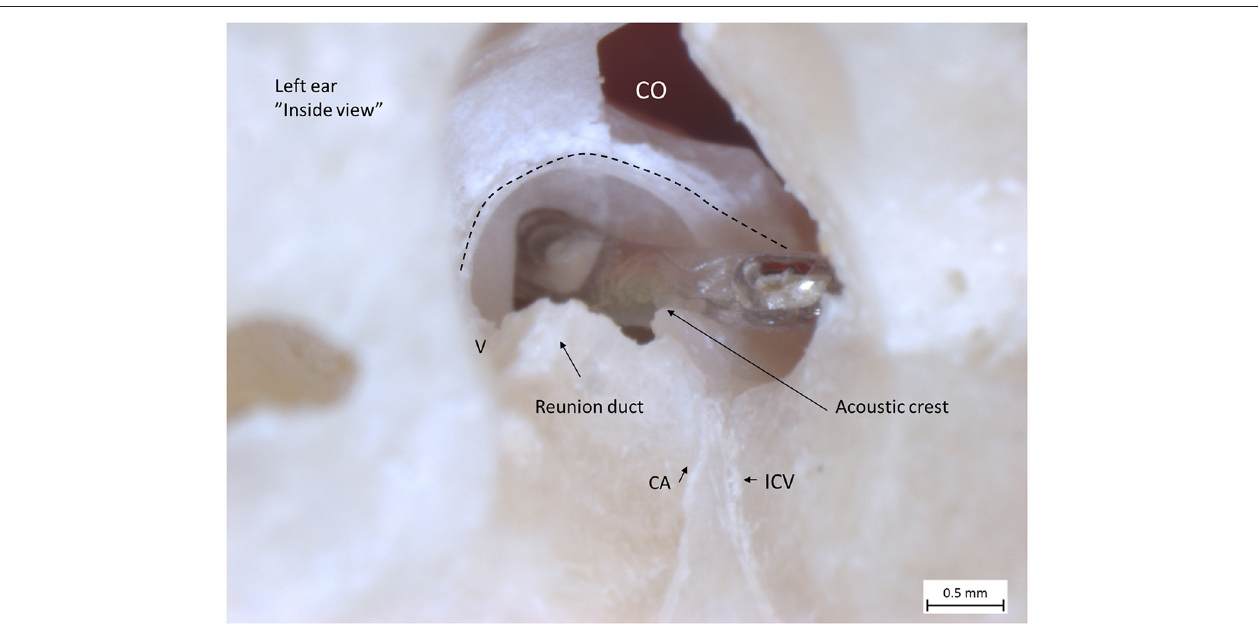
FIGURE 5 | Left human micro-dissected temporal bone (taken from the temporal bone collection of Uppsala Museum) shows the RW and acoustic crest from “inside” the labyrinth. The OSL was resected, with the secondary lamina partially preserved along the rim of the RW. The broken line shows the attachment of the BM around the RW. The electrode was inserted via the RW. It rides upon the acoustic crest before reaching the ST. An anterior CO was drilled. The CA and the inferior cochlear vein (ICV) channels were dissected as well as the